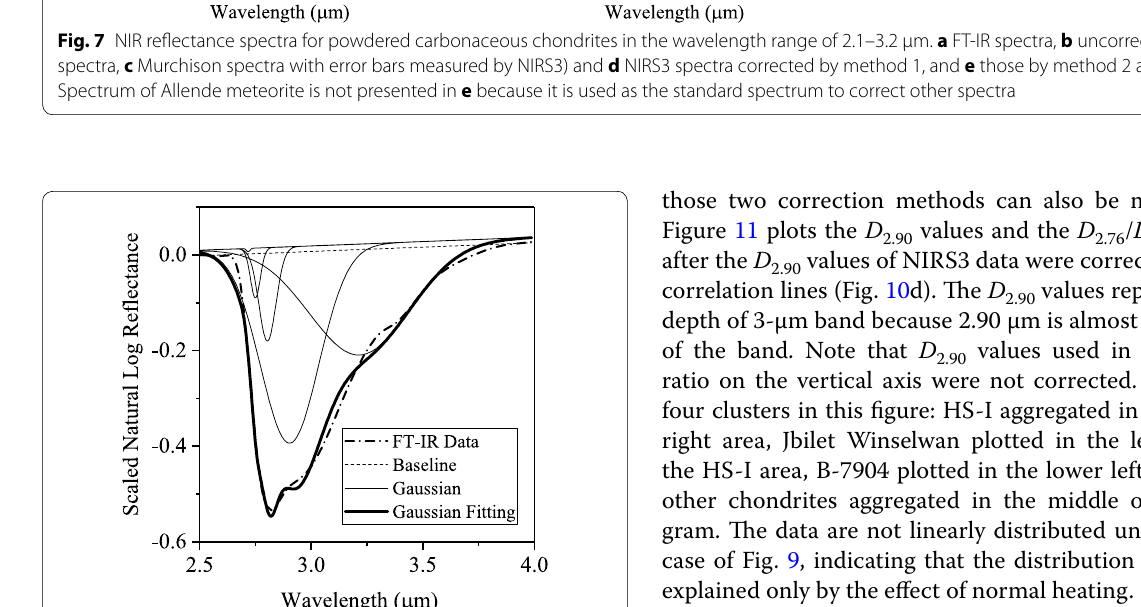
Fig. 8 MGM fitting of the 3-μm band of FT-IR spectrum of Murray